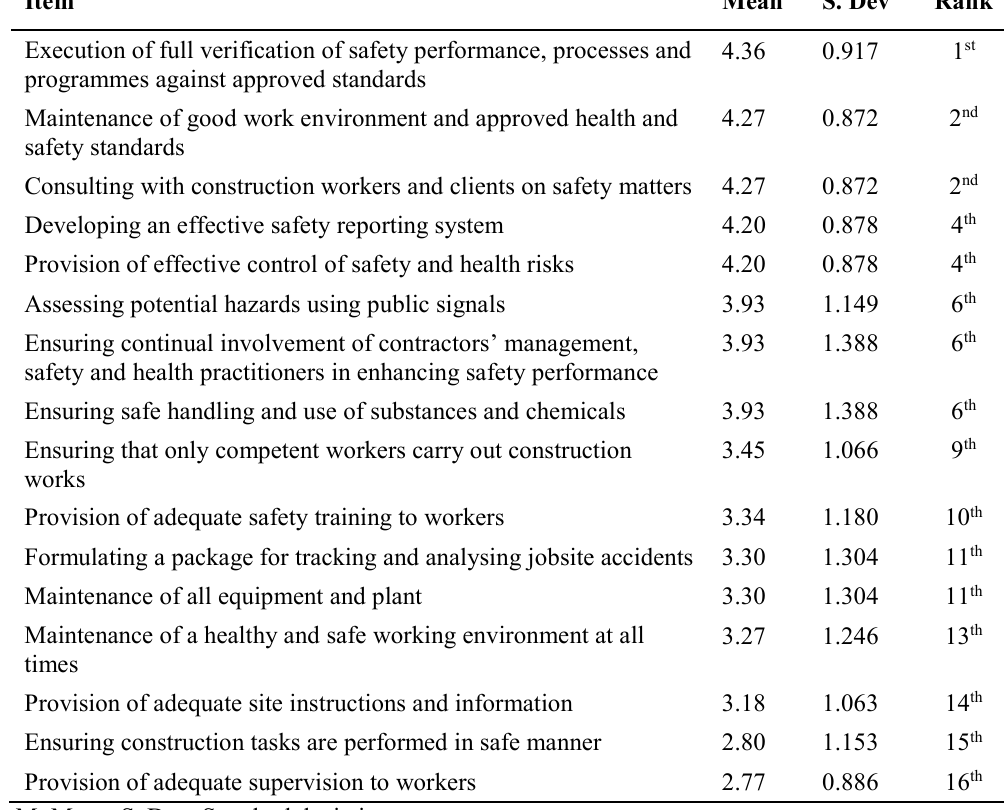
Table 4. Measures Enhancing the Implementation of Health and Safety Practices Item Mean S. Dev